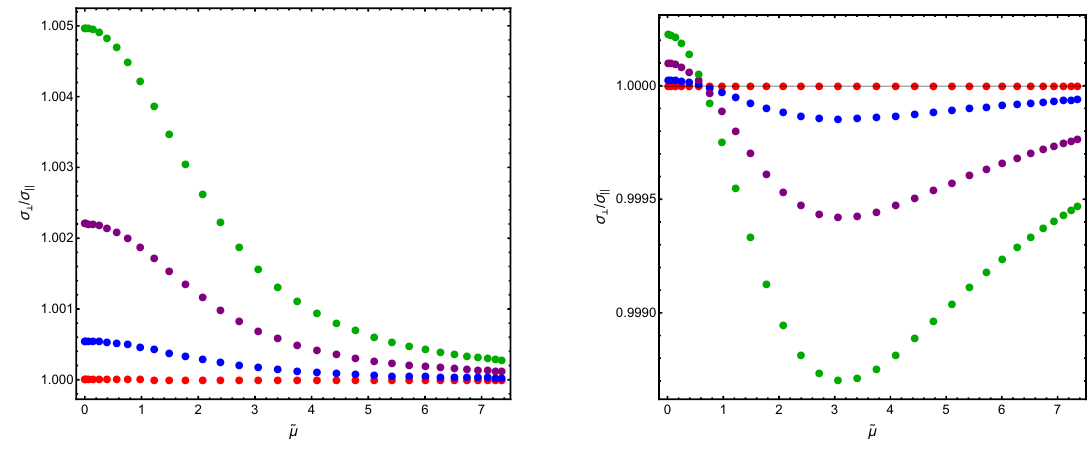
as function of ˜ µ at ||